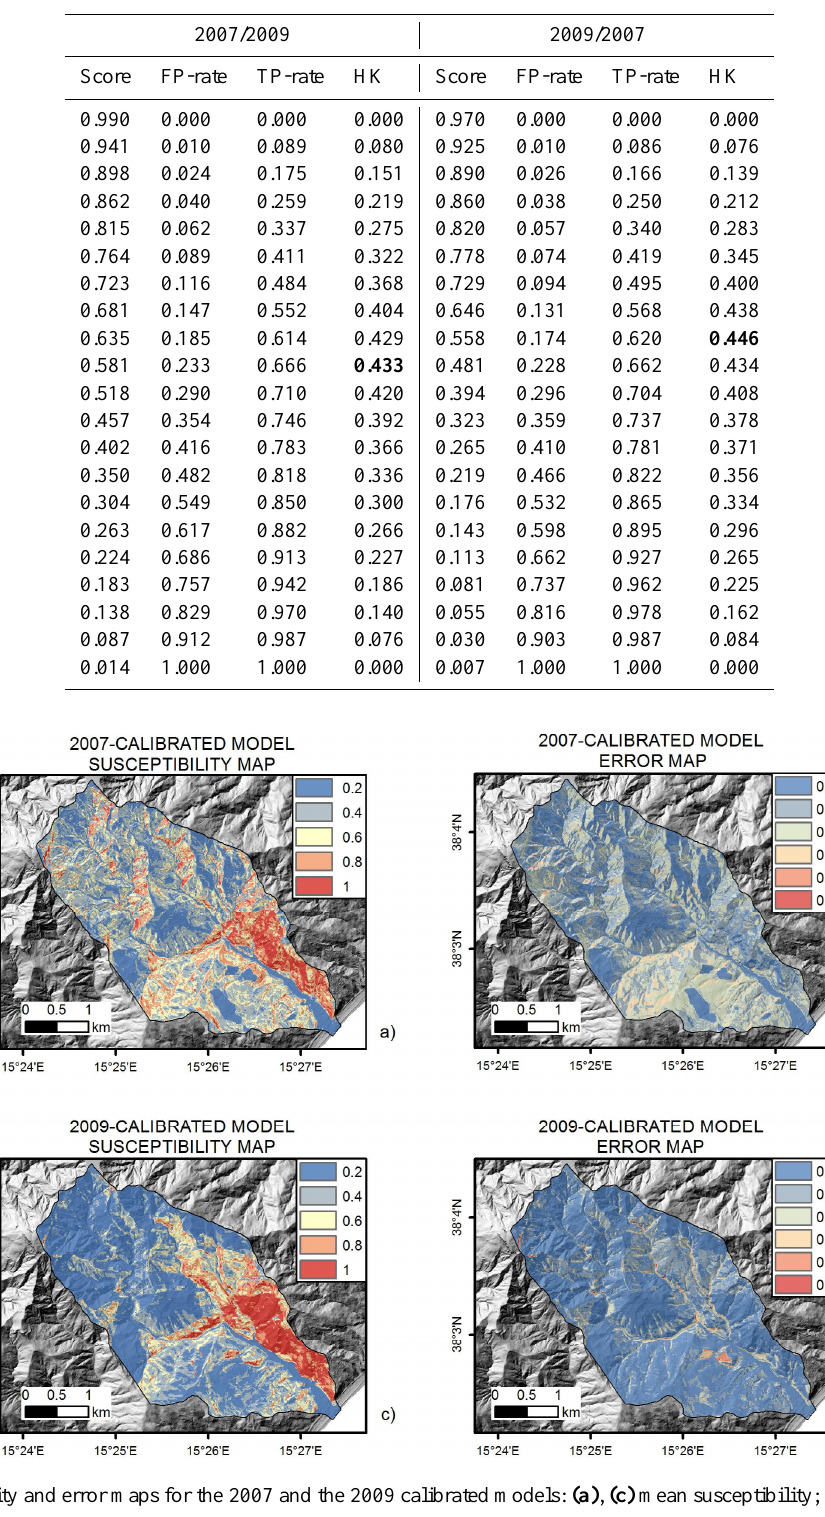
Nat. Hazards Earth Syst. Sci., 15, 1785–1806,